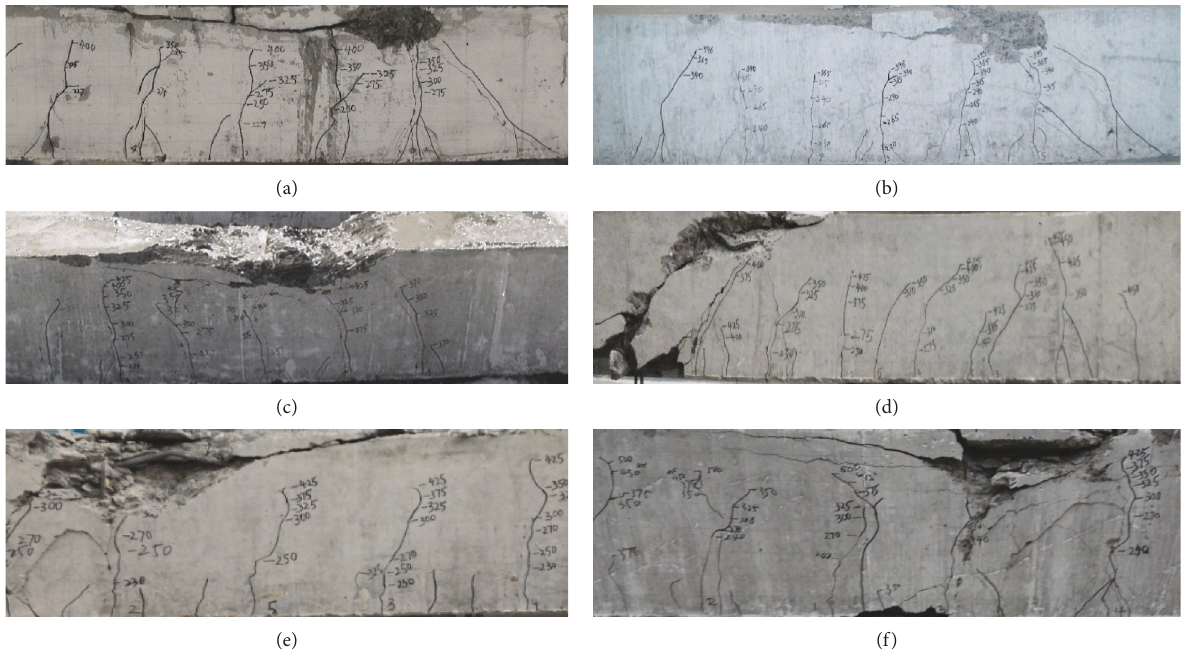
Figure 13: Crack distribution in PC girders. (a) PC 1-0-0. (b) PC 2-0-6. (c) PC 3-0-8. (d) PC 4-0-9. (e) PC 5-6-8. (f) PC